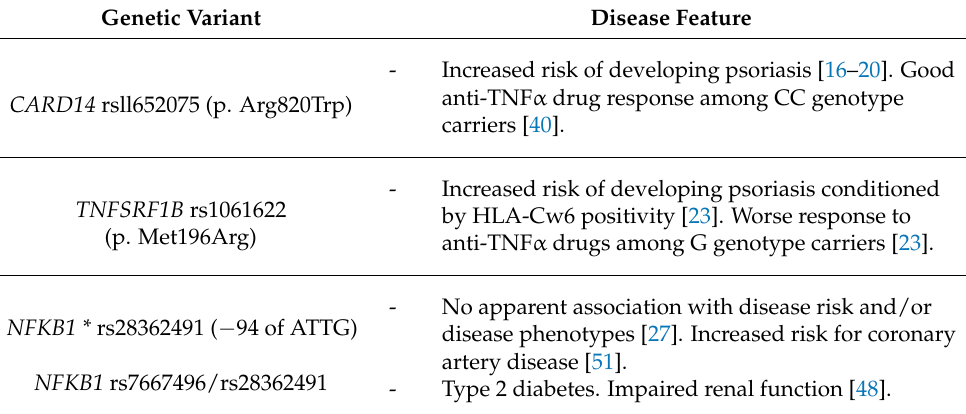
Table 1. Genetic variants within the TNF- α /NF- κ B pathway and psoriatic disease features. Genetic